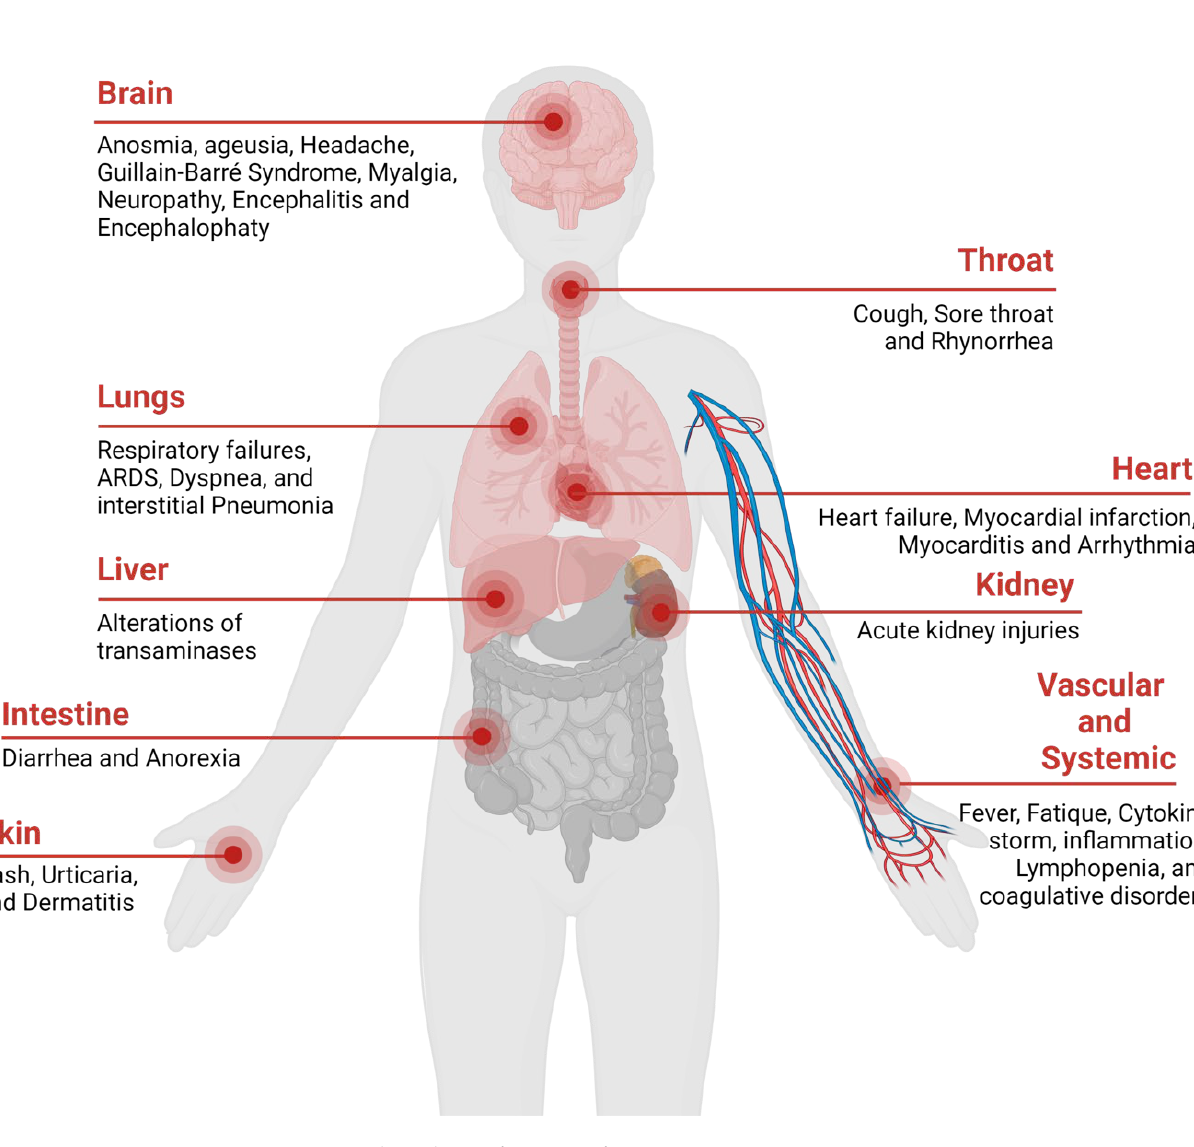
Figure 2. Clinical Manifestation of COVID-19 .